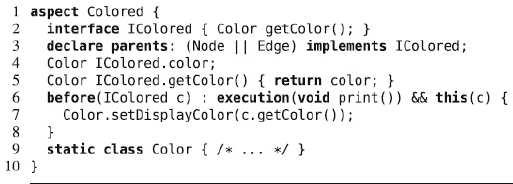
Figure 9: JPI-FM of the graph